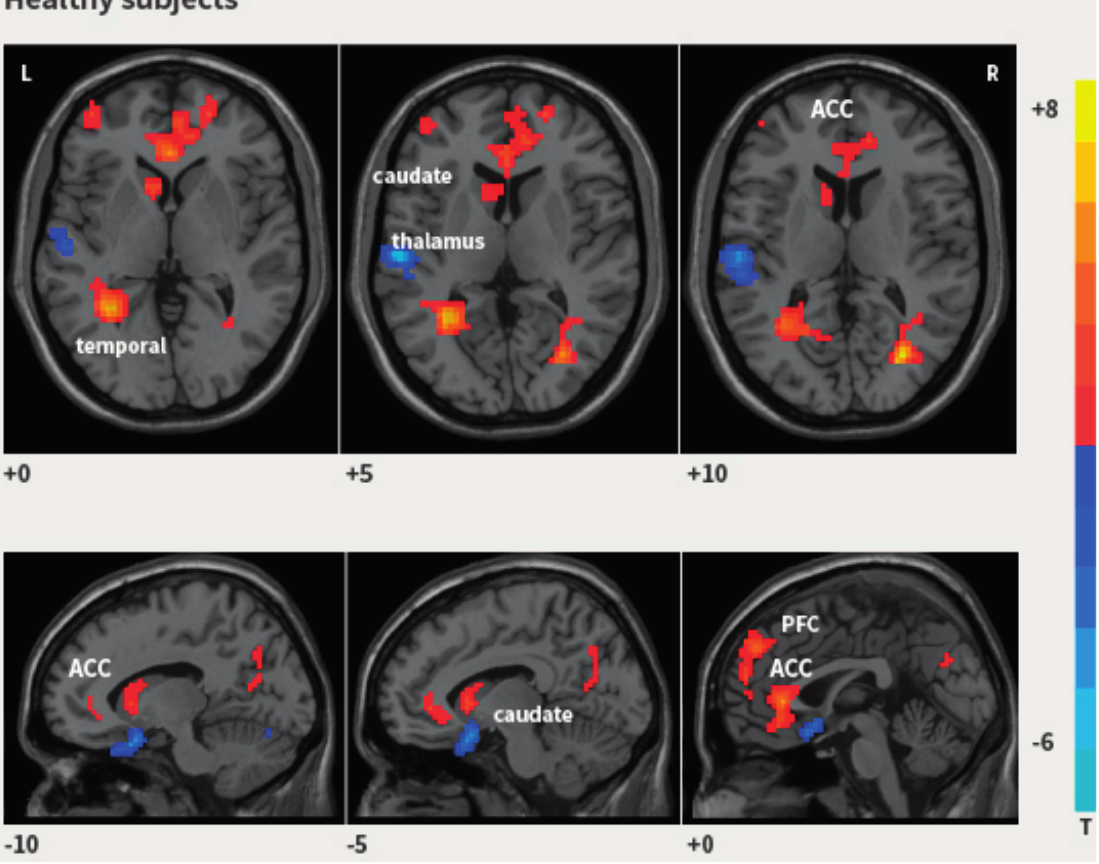
Figure 1. rs-fMRI maps showing statistically significant differences between the strong desire to void and the empty bladder. Regions with increased regional homogeneity (Reho) values are shown in red, and decreased Reho values are shown in